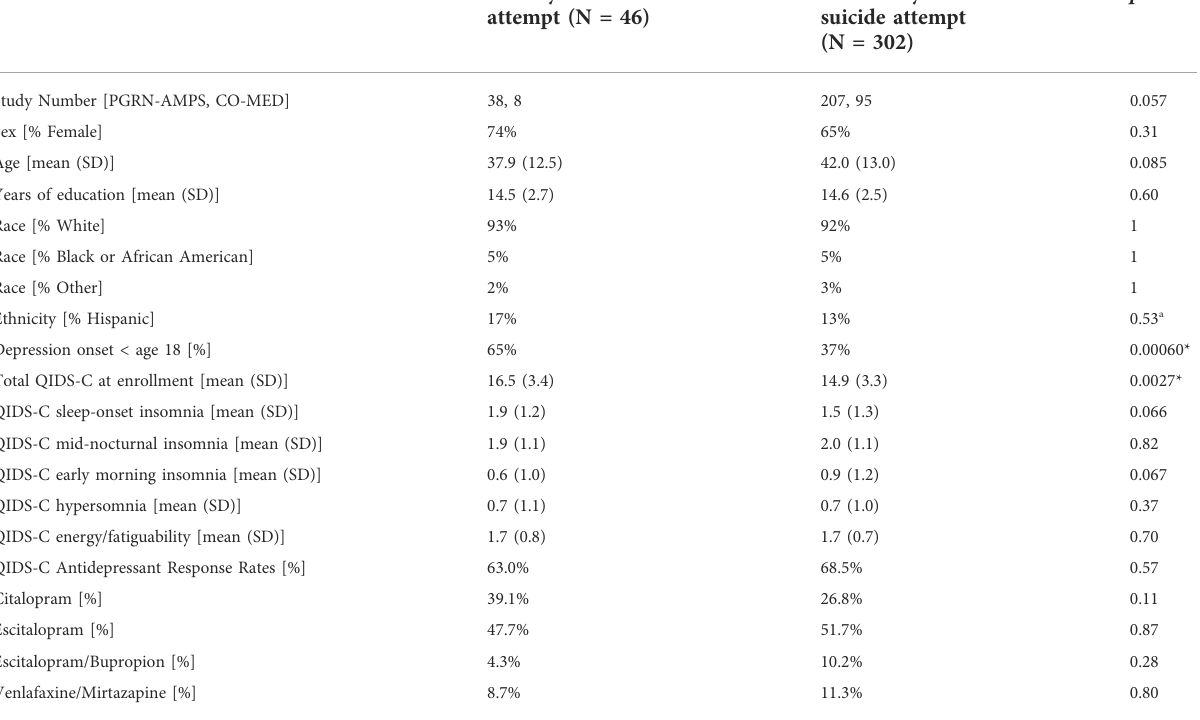
TABLE 1 Demographics and clinical